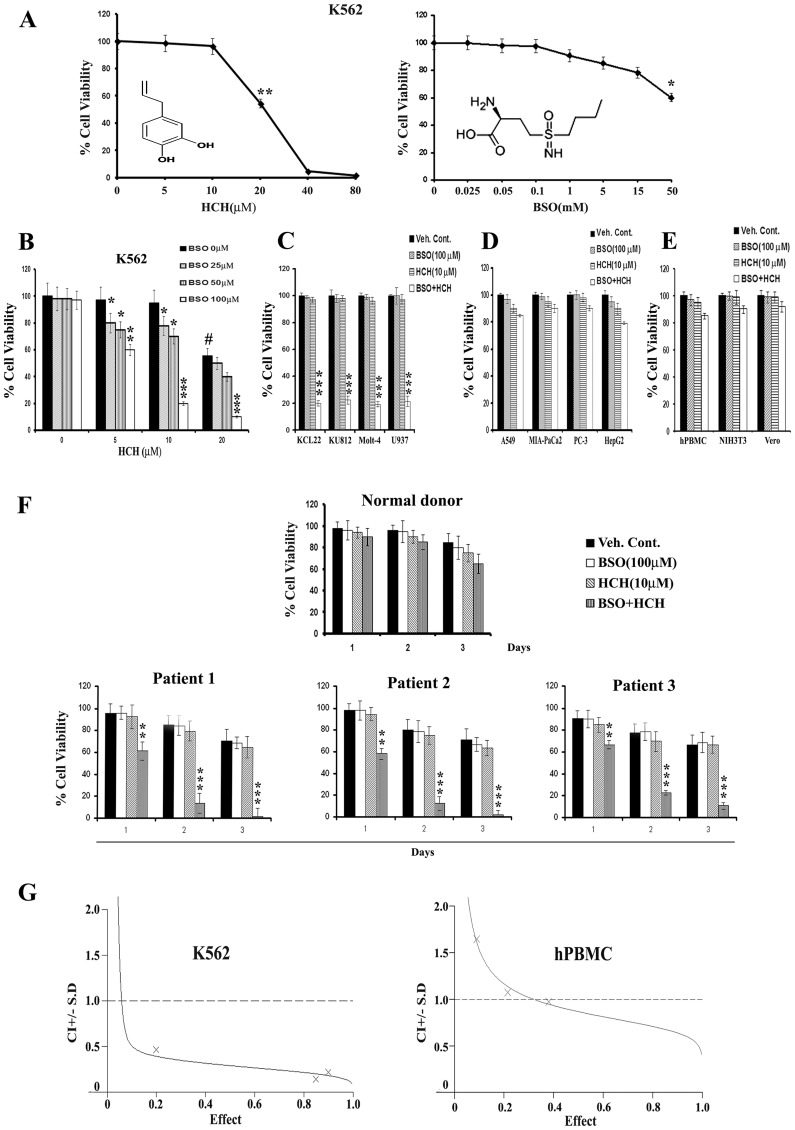
BSO potentiates HCH induced cytotoxicity in leukemic cells.(A) K562 cells were incubated with varying concentrations of HCH (left panel) and BSO (right panel) for 48 h and viability was determined by (3-(4,5-Dimethylthiazol-2-yl)-2,5-diphenyltetrazolium bromide (MTT) assay. Structures of HCH and BSO are shown within the respective graphs. * p<0.05 compared to treatment with vehicle control; ** p<0.01 compared to vehicle control. (B) K562 cells were simultaneously treated with varying concentration of BSO and HCH for 48 h. * p<0.05 compared to HCH treatment alone; ** p<0.01 compared to treatment with HCH alone; *** p<0.001 compared to HCH treatment alone; # p<0.01 compared to treatment with vehicle control or BSO. (C) Leukemic cell lines were incubated with BSO and HCH either alone or in combination for 48 h. *** p<0.001 compared to treatment with vehicle control or either of the compounds alone. (D) Same as (C) except that non-leukemic cancer cell lines were used instead of leukemic cell lines. (E) Normal cell lines or normal human peripheral blood mononuclear cells (hPBMC) were incubated with BSO and HCH either alone or in combination for 48 h. (F) PBMC from one normal donor and 3 CML patients were incubated with BSO and HCH either alone or in combination for indicated time periods and viability was determined by trypan blue dye exclusion assay. ** p<0.01 and *** p<0.001 compared to treatment with vehicle control or either of the compounds alone respectively. (A)-(F) Data represent mean ± SD of quadruplicate wells. (G) Isobologram analysis for the determination of synergy using Calcusyn software.